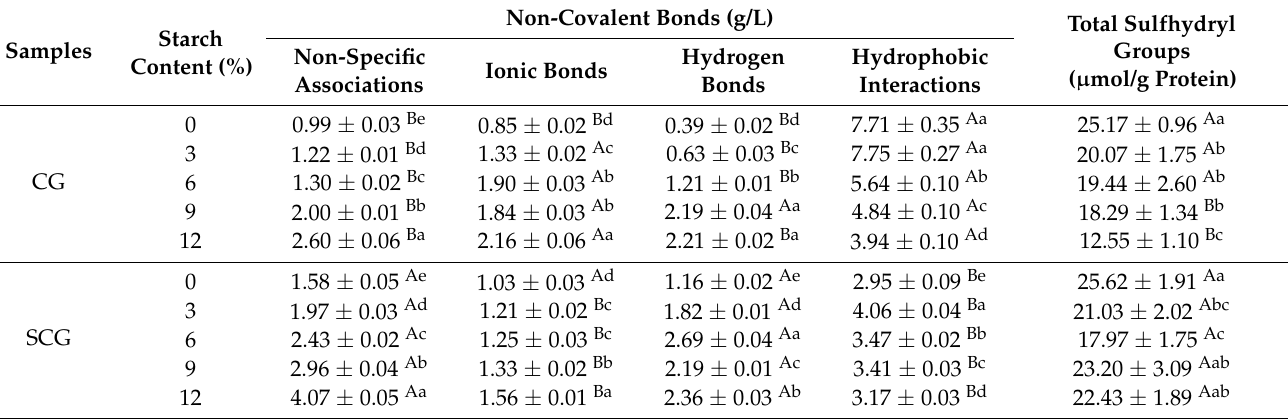
Table 2. Non-covalent bonds and total sulfhydryl groups of starch–surimi mixtures subjected with different heating